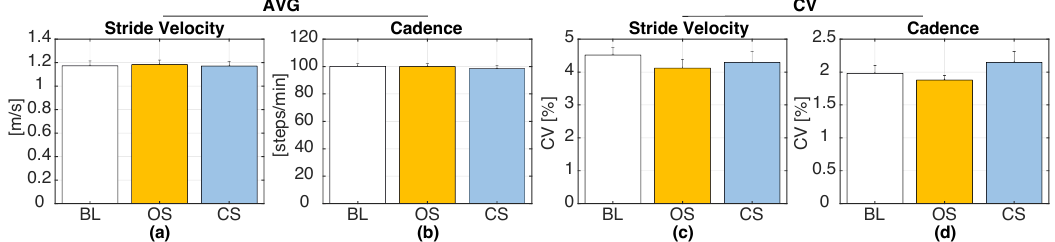
Figure 6. ( a , b ) Group averages ( AVG ) and ( c , d ) coefficient of variation ( CV ) of SV and CAD induced by the two stimulation modes (OS = open-loop vibrotactile stimuli, CS = closed-loop vibrotactile stimuli) during Session 1 (S1), as compared to their baseline (BL) values. Error bars indicate ±